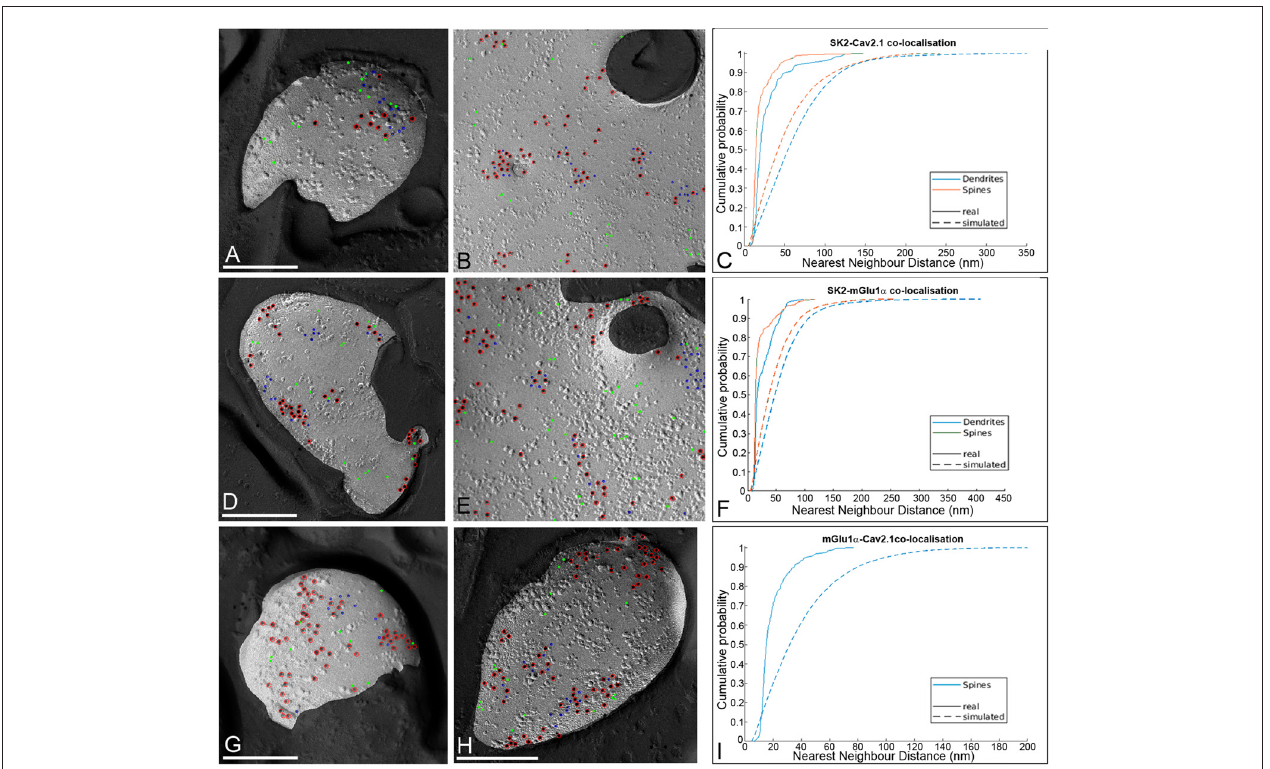
FIGURE 7 | Spatial relationship between SK2, Ca V 2.1 and mGlu 1 α in PCs. (A) Example showing random simulation of immunoparticles for Ca V 2.1 in a dendritic spine. (B) Example showing random simulation of immunoparticles for Ca V 2.1 in a dendritic shaft. Red, real SK2; blue, real Cav2.1; green, simulated Cav2.1. (C) Cumulative probability plot of NND from SK2 to Ca V 2.1 particles in dendrites (blue) and spines (red). Solid: real NND between SK2 and Ca V 2.1; Dashed: simulated NND. The SK2 to Ca V 2.1 NNDs were significantly smaller than the random NNDs in dendritic shafts and spines ( p < 0.05, pairwise Mann–Whitney U test, numbers of profiles analyzed for spines and dendrites should be indicated). (D) Example showing random simulation of immunoparticles for mGlu 1 α in a dendritic spine. (E) Example showing random simulation of immunoparticles for mGlu 1 α in a dendritic shaft. Red, real SK2; blue, real mGlu 1 α ; green, simulated mGlu 1 α . (F) Cumulative probability plot of NND from SK2 to mGlu 1 α particles in dendrites (blue) and spines (red). Solid: real NND between SK2 and mGlu 1 α ; Dashed NND: simulated. The SK2 to mGlu 1 α NNDs were significantly smaller than the random NNDs in dendritic shafts and spines ( p < 0.05, pairwise Mann–Whitney U test, numbers of profiles analyzed for spines and dendrites should be indicated). (G,H) Examples showing random simulation of immunoparticles for Ca V 2.1 in dendritic spines. Red, real mGlu 1 α ; blue, real Cav2.1; green, simulated Cav2.1. (I) Cumulative probability plot of NND between Ca V 2.1 and mGlu 1 α particles in spines (blue). Solid: real NND between mGlu 1 α and Ca V 2.1; Dashed: simulated. The mGlu 1 α to Ca V 2.1 NNDs were significantly smaller than the random NNDs in dendritic spines ( p < 0.05, pairwise Mann–Whitney U test, number of profiles analyzed should be